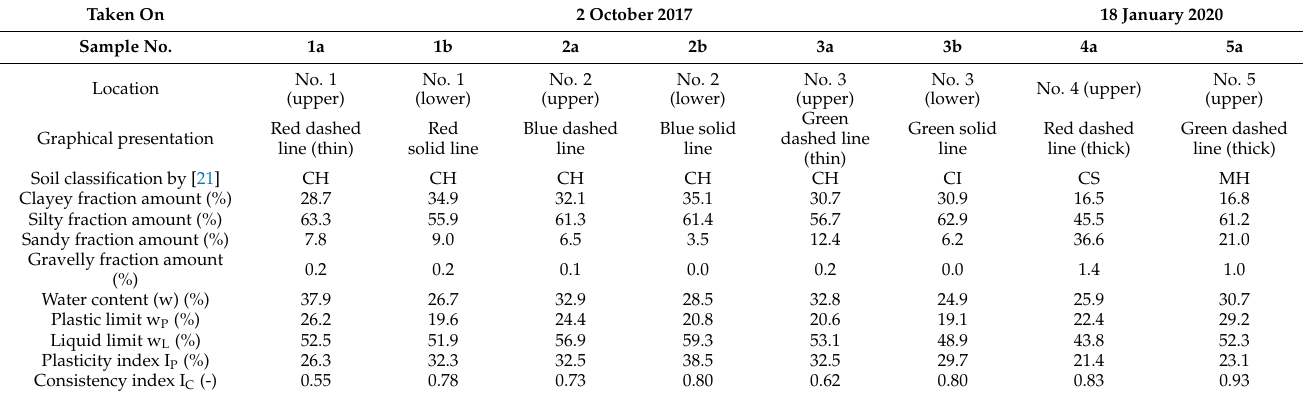
Figure 9. Grain size distribution diagram of the soils. Upper six curves (six samples taken on 22 October 2017): Thin red dashed line and solid line: Location 1, top and down sample; thin blue dashed line and solid line: Location 2, top and down sample; thin green dashed line and solid line: Location 3, top and down sample [17]. Lower two curves (two samples taken on 18 January 2020): The lowest thick red dashed line: Location 4, top sample, approximately 0.5 m from location 1; the lowest thick green dashed line: Location 5, top sample, approximately 0.5 m from location 3). Table 1. Soil properties on 02 October 2017 (samples 1a–3b) [17] and 18 January 2020 (samples 4a and 5a). Taken